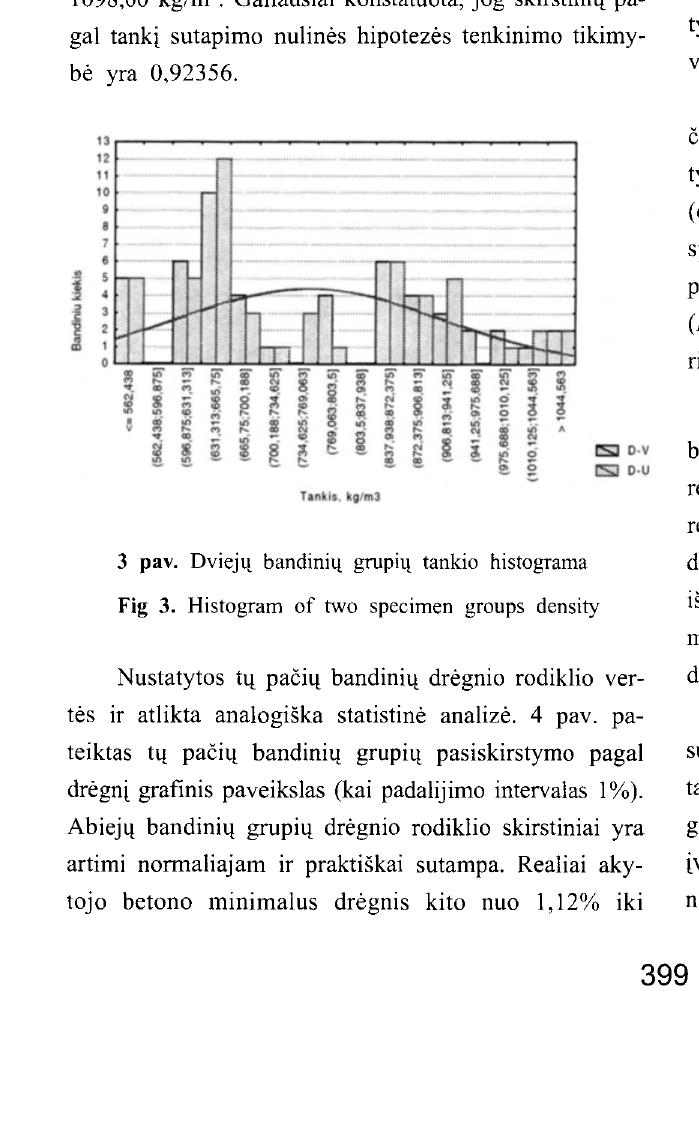
Fig 4. Histogram of two specimen groups humidity IS to seka, jog 1yginamiesiems atsparumo sa1Ciui tyrimams atrinkti identiski bandiniai, kurie atstovauja visai tiriamai akytojo betono aibei. Atlikus akytojo betono abiej4 grupi4 atsparumo sa1- ciui (sa1dant turiniu budu ir vienpusiai) 1yginamuosius tyrimus buvo atlikta ir gautq atsparumo sa1ciui rodik1itt (cik1ais) regresine ana1ize. Akivaizdu (5 pav.), kad at sparumo salciui rodiklio sa1dant vienpusiai ( F-V1) prognoze paga1 rezultatus, gautus sa1dant ruriniu budu (F- V1 ), ir orientuojantis i suirimo pradzi~ pagal empi